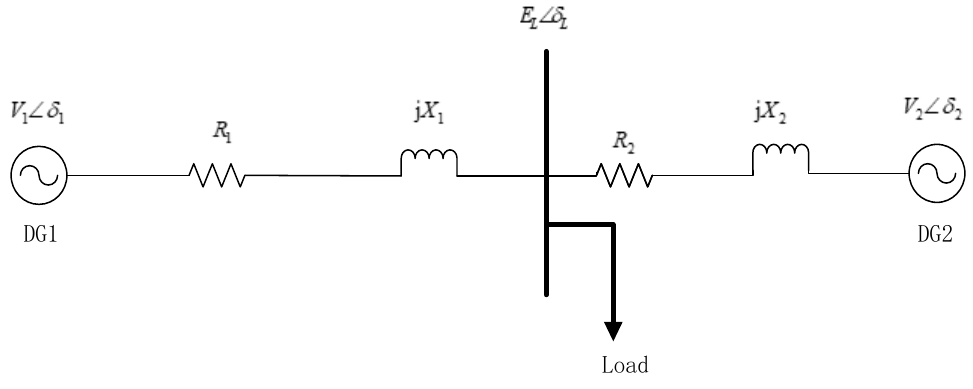
Figure 2. Schematic diagram of line node currents.